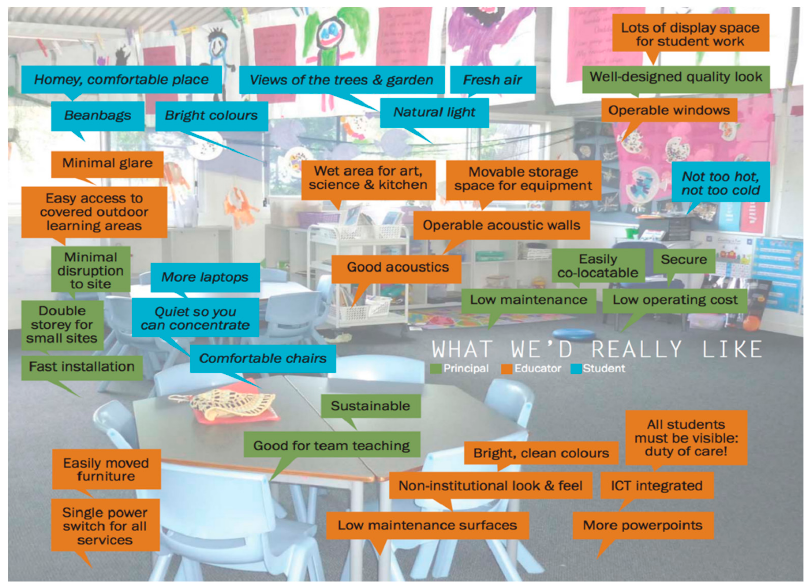
Figure 7. Priorities for users of prefabricated learning spaces. Image: Future Proofing Schools.